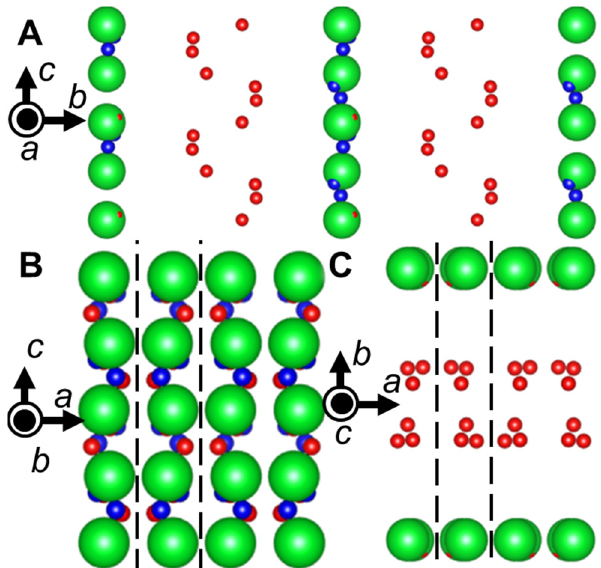
Figure 7. Crystal structure of SBO [6]. ( A ): (100) face perpendicular to the paper; ( B ): (010) face perpendicular to the paper; ( C ): (001) face perpendicular to the paper. Green, red, blue balls correspond to strontium, oxygen, and boron atoms, respectively. Symbols in the individual drawings show the crystallographic orientation. Dashed lines depict the position of mirror planes.